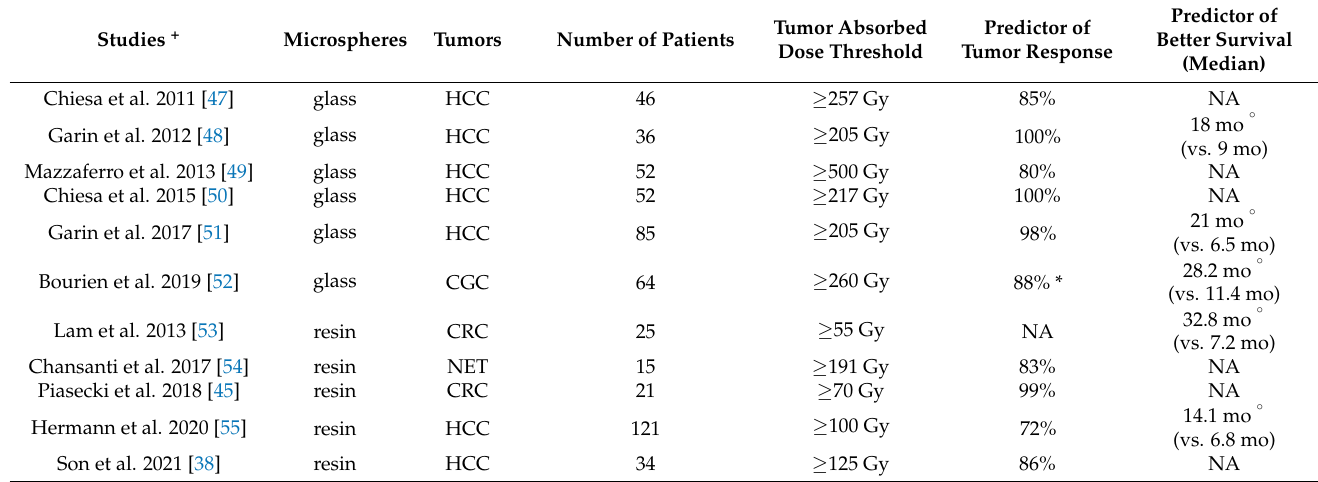
Table 4. MAA tumor absorbed doses thresholds correlated to SIRT